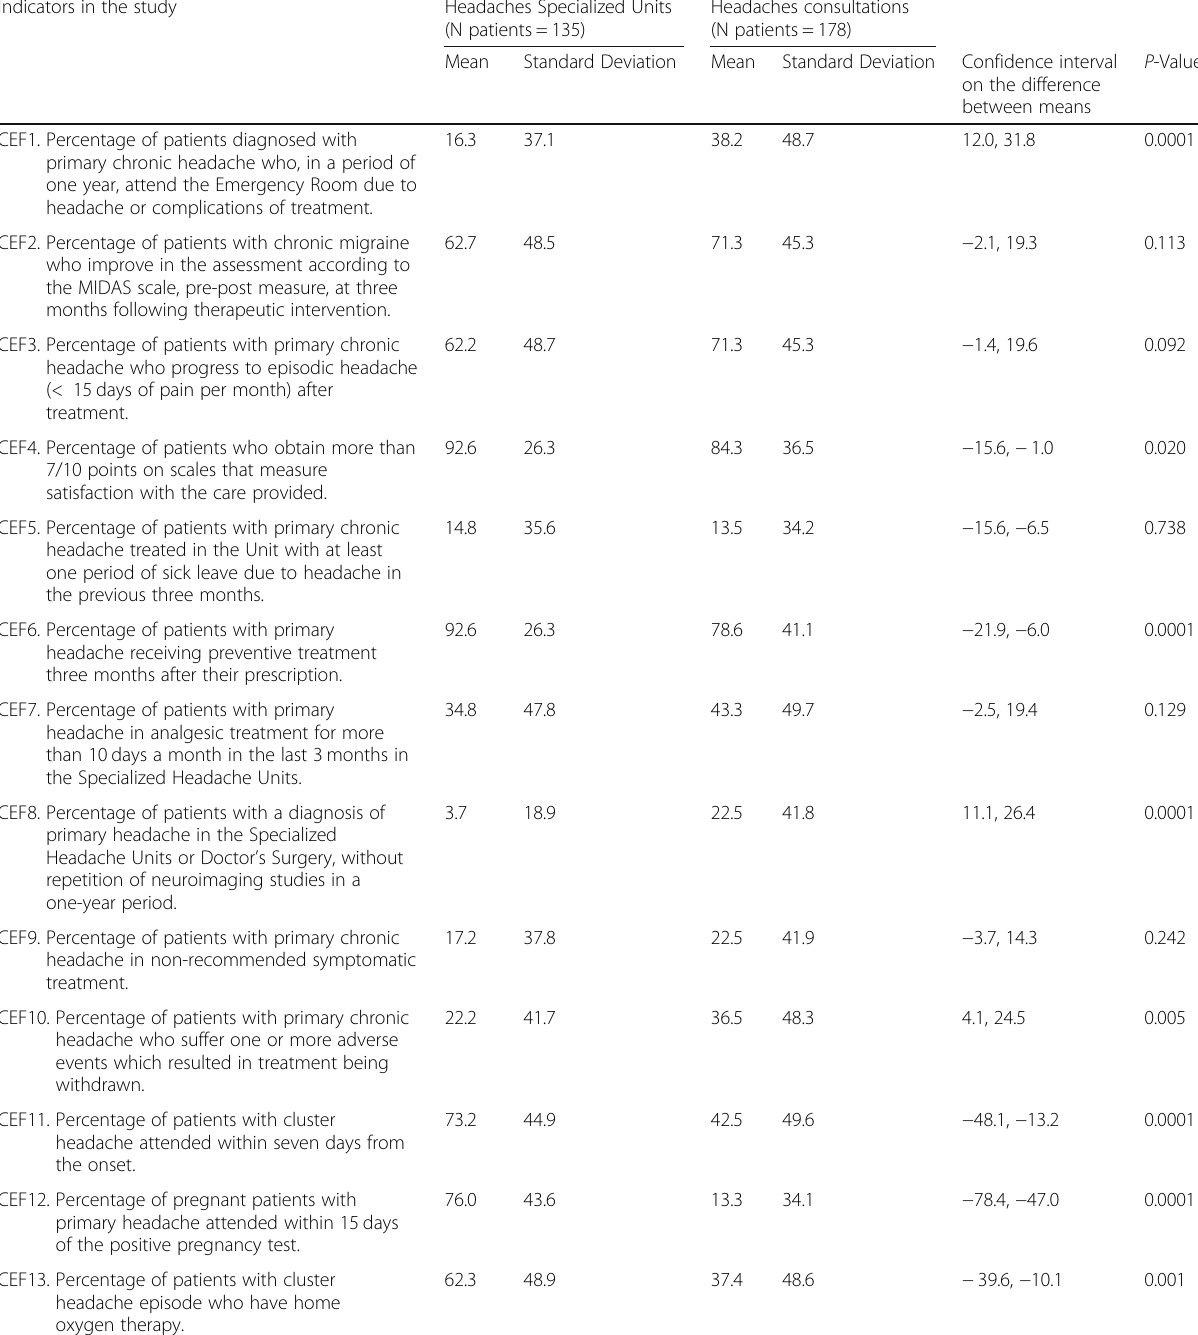
Table 5 Results in the indicators according to the complexity of cases attended in the centers participating in the study Indicators in the study Headaches Specialized Units